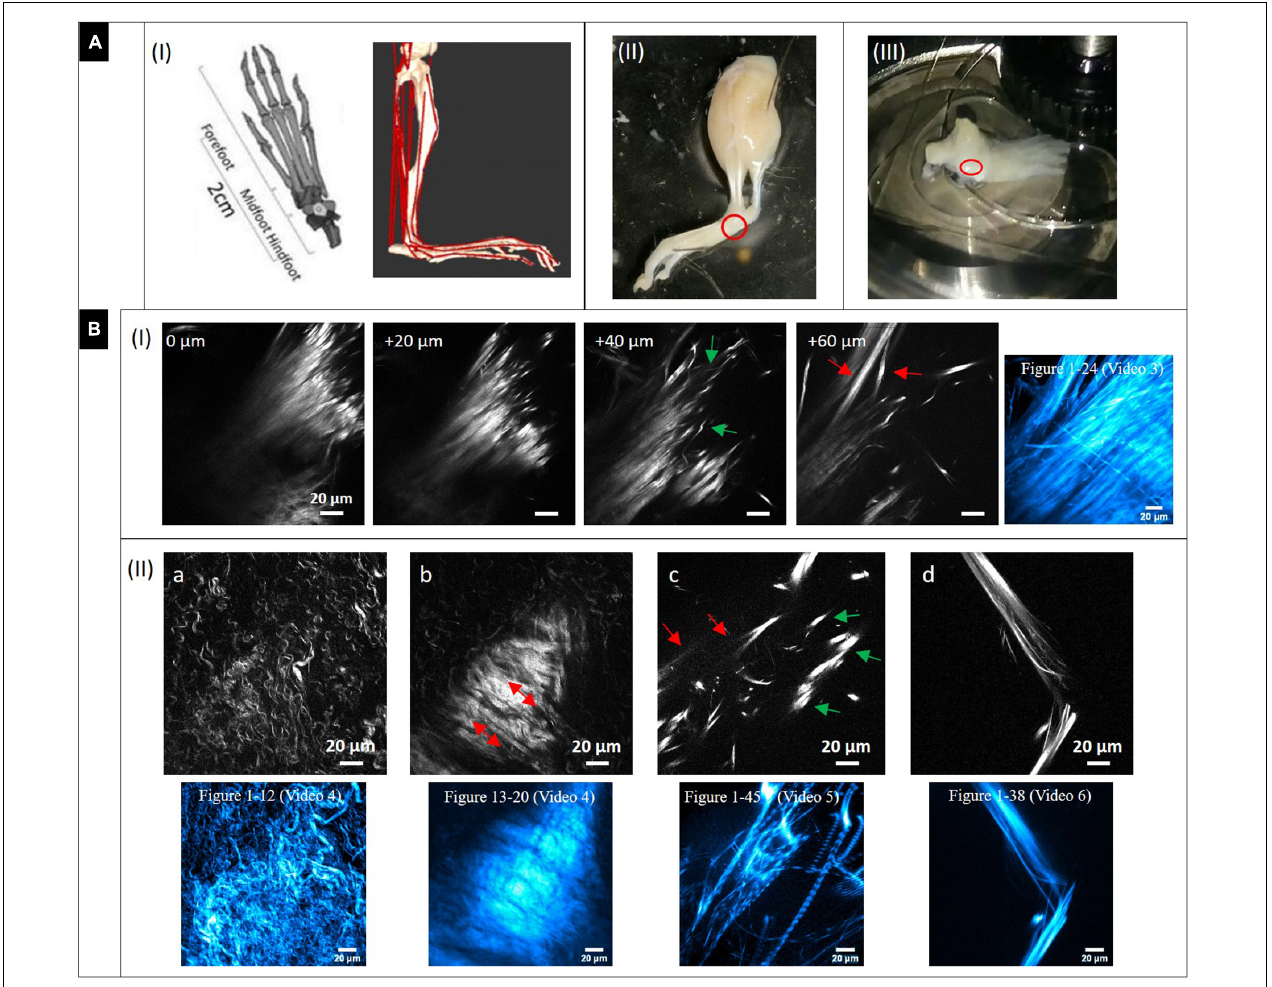
FIGURE 3 | Dissection of mouse paw and multiphoton SHG imaging after decalcification. (A) Mouse paw. (I) Anatomy of mouse foot and ankle. (Left) Graphical depiction of skeletal model (transverse plane view, from Gao et al., 2019). Creative Commons Attribution License (http://creativecommons.org/licenses/by/4.0). (Right) Musculoskeletal model of a mouse’s right hindlimb (craniolateral view) developed with biomechanics software (from Charles et al., 2016 section of Figure). Musculo-tendon units (red) were incorporated into the model. The image shows a multitude of tendon structures running through the metatarsus region. (II) Skinned and PFA-fixed mouse foot. The metatarsus region is marked (red circle). (III) The lower foot was isolated and all muscle tissue on the sole entirely dissected, then it was placed in a glass bottom dish on top of the objective to optically access the region of interest (red circle). (B) Multiphoton SHG images from the metatarsus region (200 µ m × 200 µ m, 1,024 × 1,024 pixels). (I) Images series of a region of interest at increasing depths and (II_a-d) images of various regions showing areas with very different collagen-I fiber morphologies and arrangements. Z-projections of the complete image sequences (images in cyan) show the global organization of collagen network (compare to Supplementary Videos ). Images (a,b) are from the same